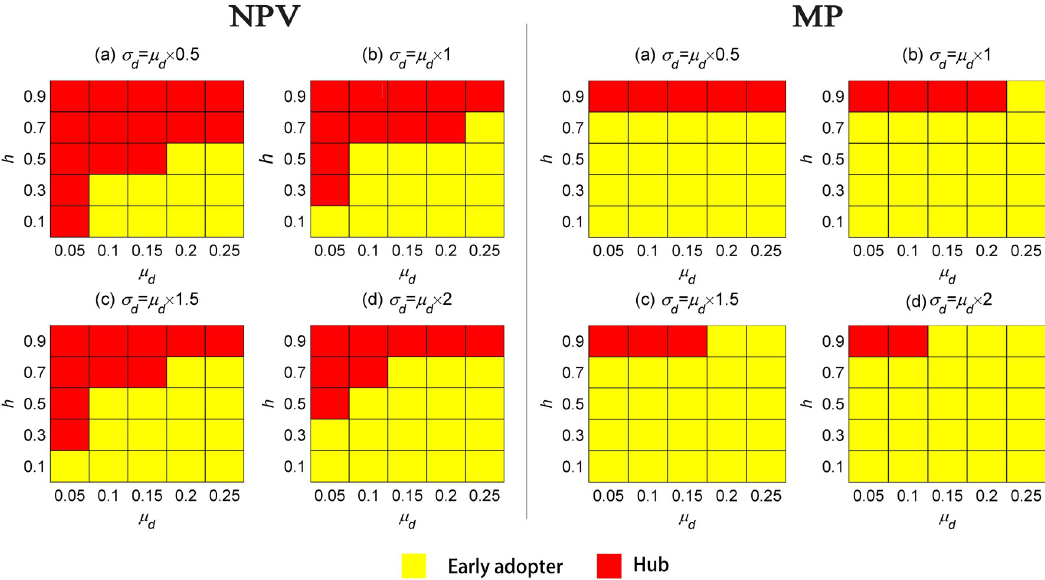
Fig 4. Optimal seeding targets at the combinations of three factors. Each of the above figures is determined based on the standard deviation of the probability of spreading negative WOM. The x -axis of each plot is the mean of the probability of spreading negative WOM, while the y -axis is the level of homophily. Each square corresponds to a situation of combination of the three factors. The yellow color block indicates that the optimal seeding targets under this situation are early adopters, while the red color block represents the